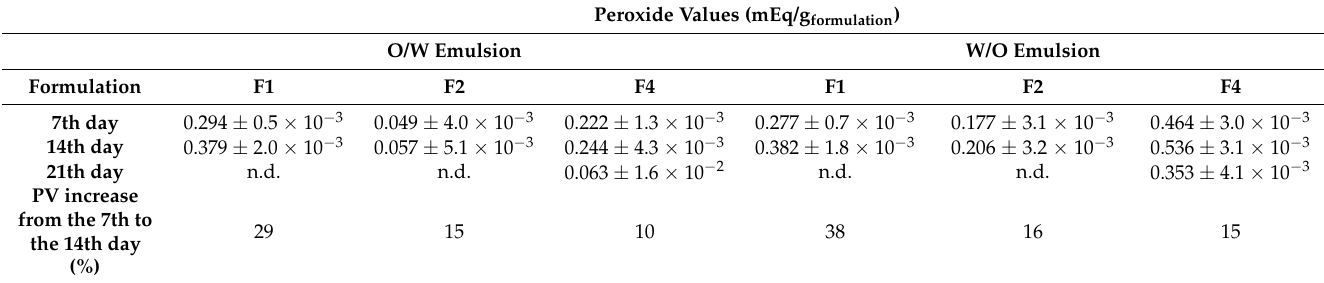
Table 2. Peroxide values after the 7th, 14th and 21st day of production for the O/W and W/O formulations F1, F2 and F4, and the percentage increase from the 7th to the 14th day. Peroxide Values (mEq/g formulation ) O/W Emulsion W/O Emulsion